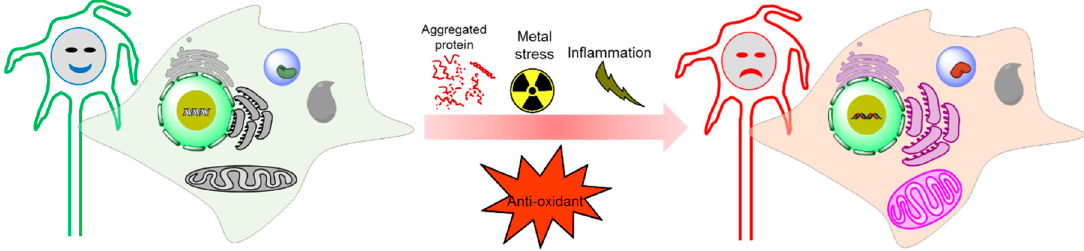
Figure 4. Physiological condition versus tauopathy condition by oxidative stress generation. Table 1. Potential oxidative markers in tauopathies. (up-regulation is labeled as up-arrow, and down- regulation is labeled as down-arrow)